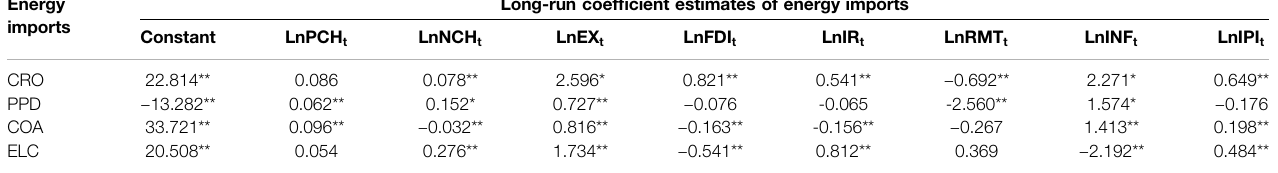
TABLE 3 | NARDL long-run estimates.